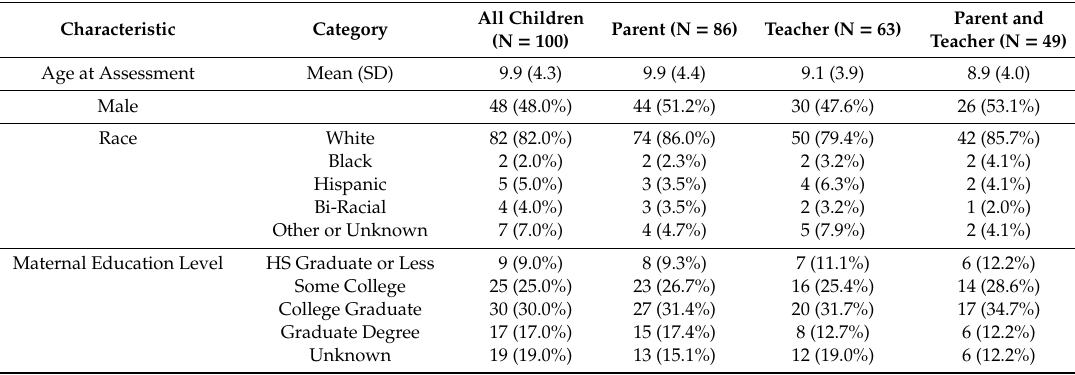
Table 1. Characteristics of Study